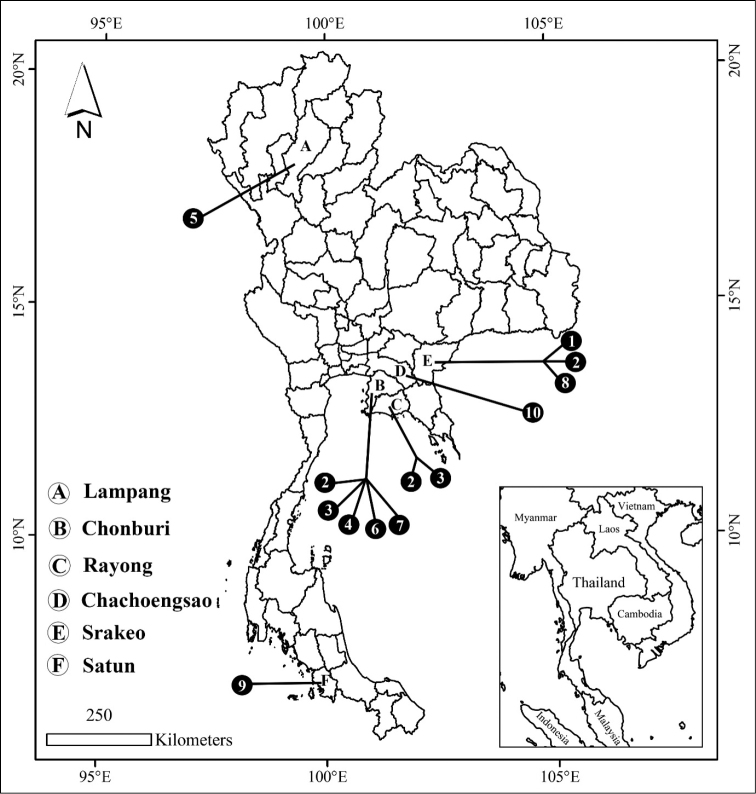
Distribution map of Aulacospira spp. in Thailand: 1A.
depressa2A.
khaopratun3A.
panhai4A.
khaobote5A.
lampangensis6A.
smaesarnensis7A.
pluangtong8Aulacospira
tekavongae sp. nov. 9Aulacospira
nudtadhirai sp. nov. 10Aulacospira
vanwalleghemi sp. nov.